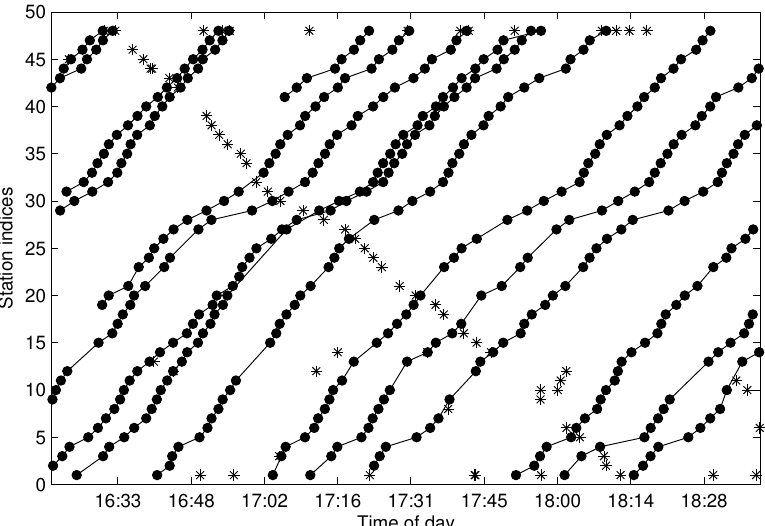
Figure 18. The final extracted trajectories after adding the arrival data of the first and final stations